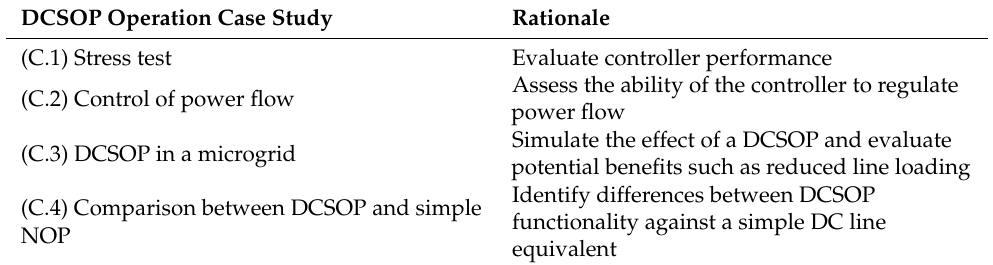
Table 1. Rationale behind the set of case studies used for evaluating DCSOP operation.